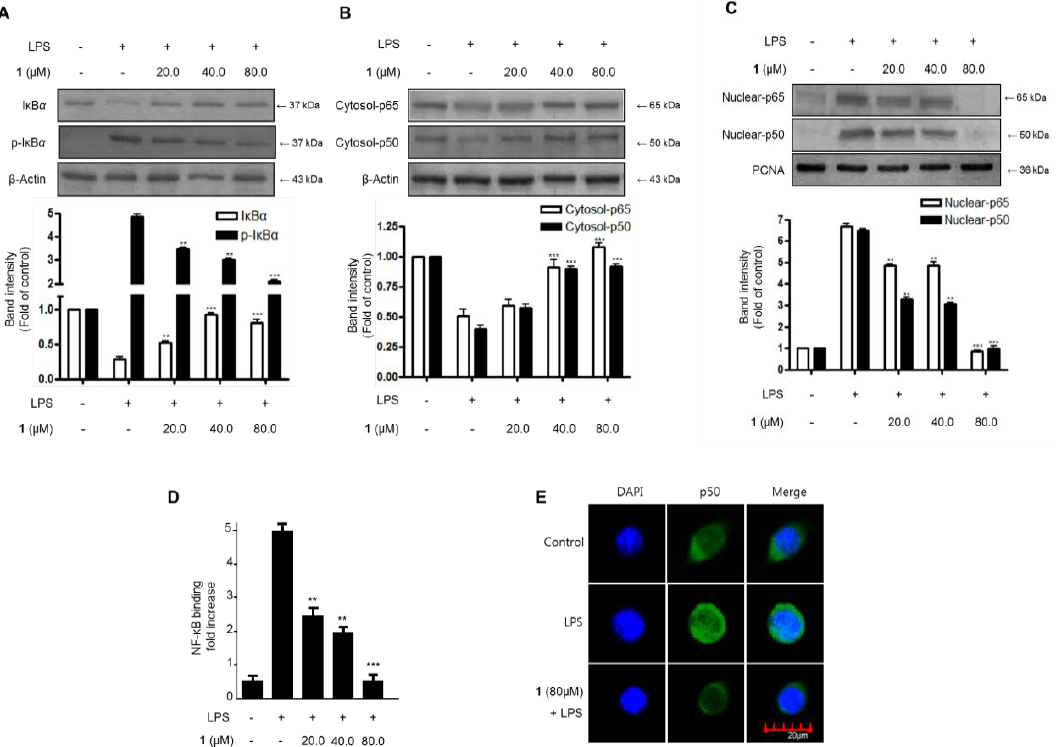
Figure 5. The effects of steppogenin ( 1 ) on I κ B- α phosphorylation and degradation ( A ) NF- κ B activation ( B , C ), NF- κ B DNA binding activity ( D ), and NF- κ B localization ( E ) in LPS-stimulated BV2 microglial cells. ( A – E ) The cells were pretreated for 3 h with the indicated concentrations of 1 and then stimulated for 1 h with LPS (1 µ g/mL). The data are presented as the mean ± SD of three experiments. The band intensity was quantified by densitometry and normalized to the intensity of the β -actin or proliferating cell nuclear antigen (PCNA) band; the normalized values are presented below each band. ** p < 0.01; *** p < 0.001 compared with the LPS-treated